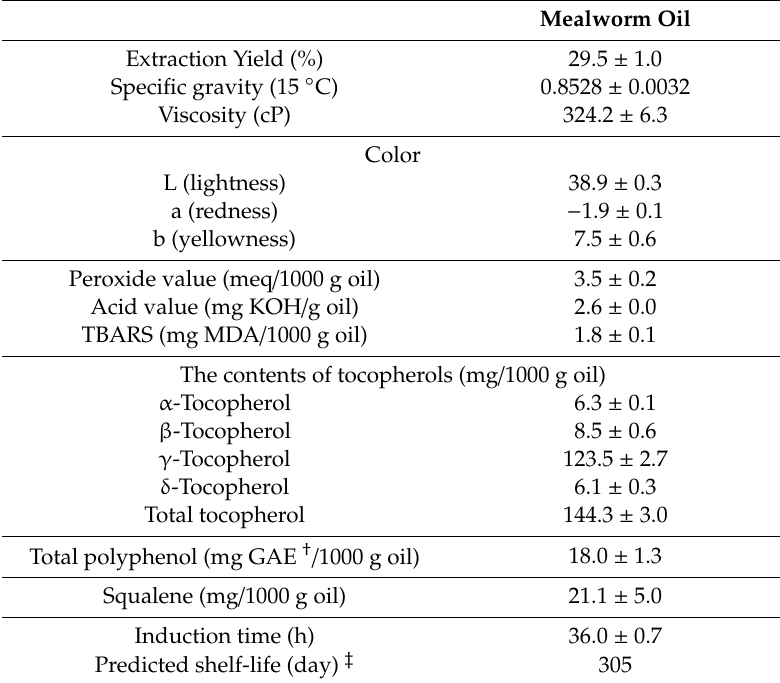
Table 4. Physicochemical properties and nutrient composition of mealworm